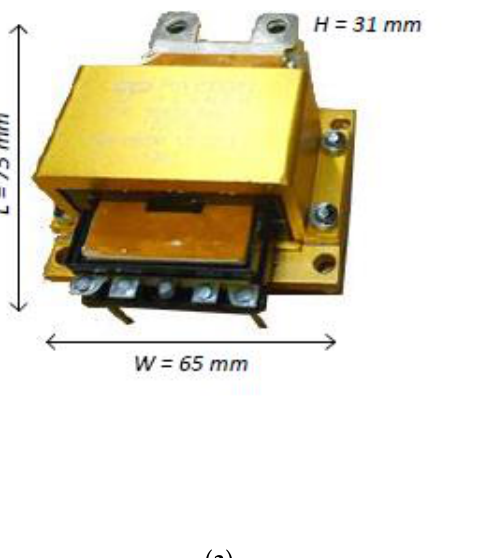
Figure 4. Photograph of planar magnetic components: heat-sinked inductor, ( a ), and transformer, ( b ).